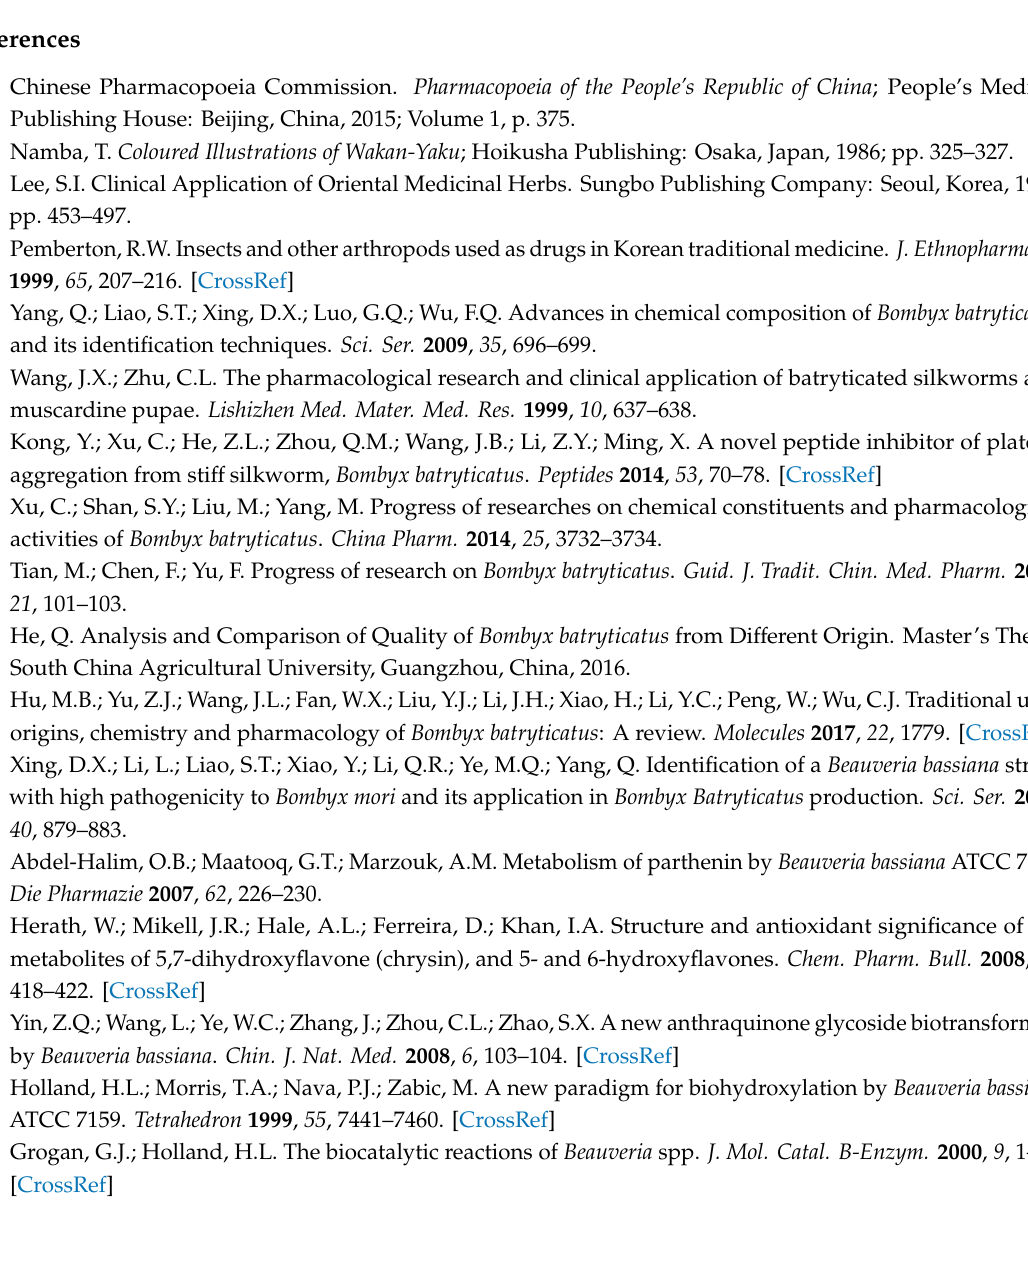
Figure S1: Representative base peak intensity chromatograms of healthy silkworm SW ( a ), D1 Bombyx batryticatus ( b ), D5 B. batryticatus ( c ) and D9 B. batryticatus ( d ), Table S1: Di ff erential metabolites identified based on VIP > 1, p -value < 0.05, Table S2: Mass spectrometric data of lipids in Bombyx batryticatus